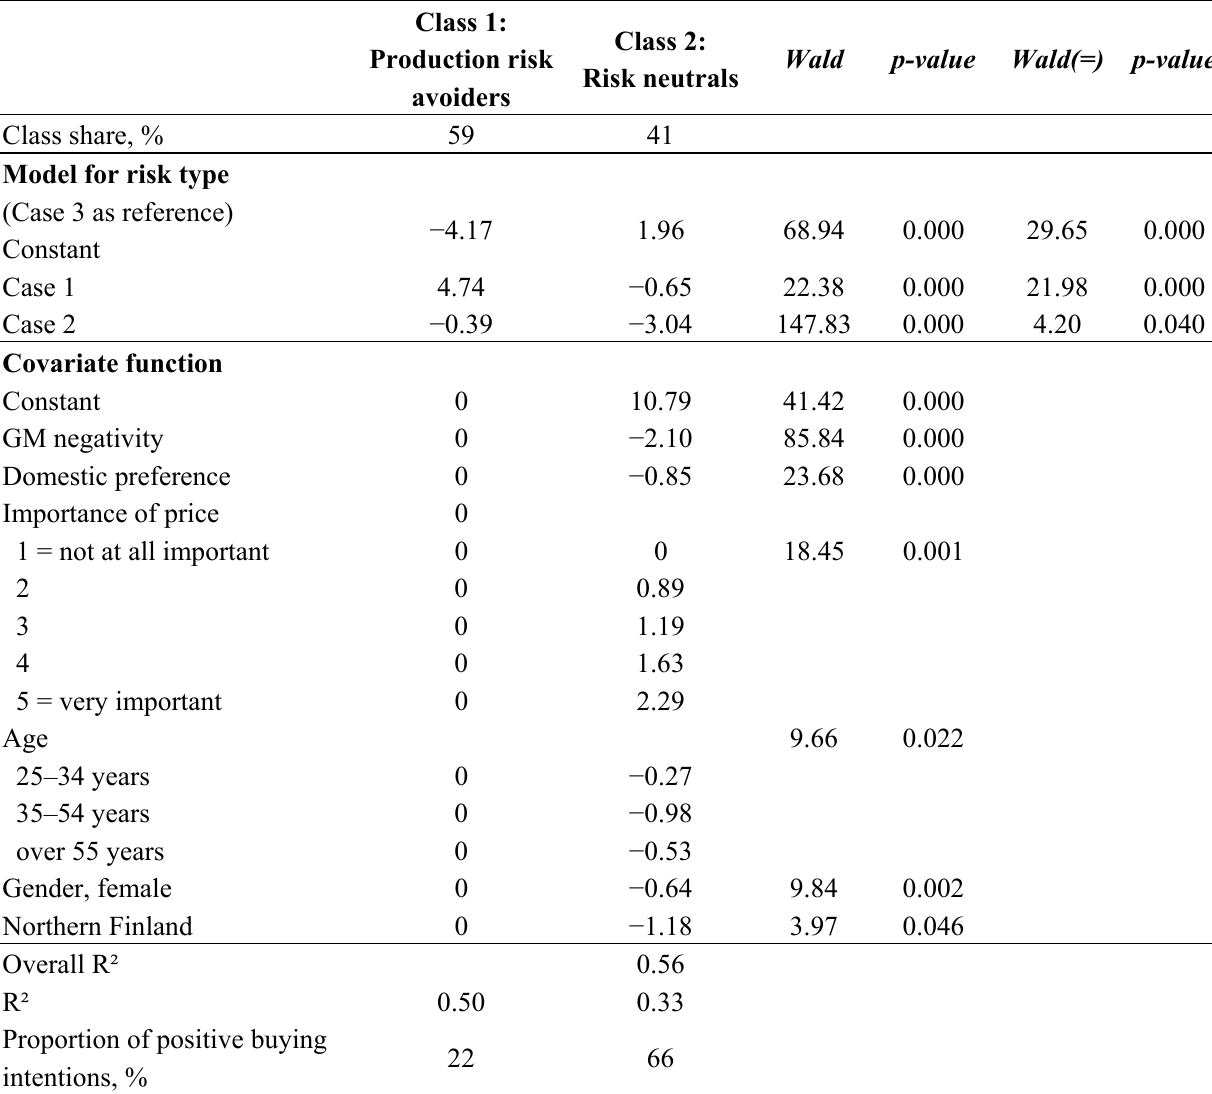
Table 6. Latent class logistic regression for purchase intentions. Class membership is explained with the